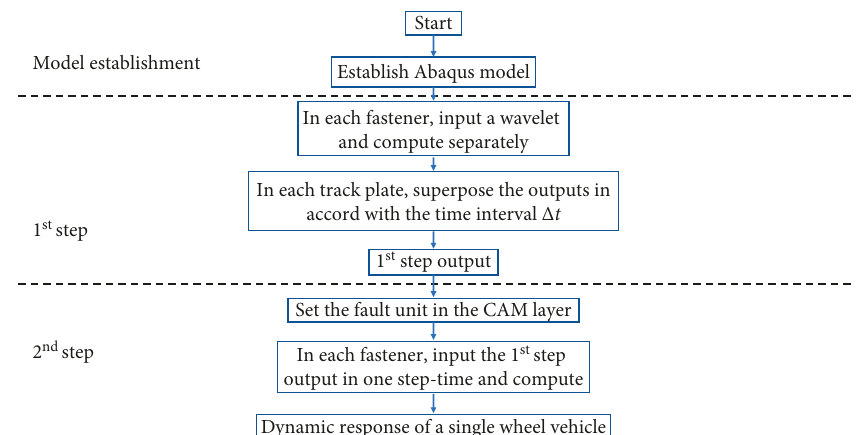
Figure 3: Flowchart for the dynamic response computational method.